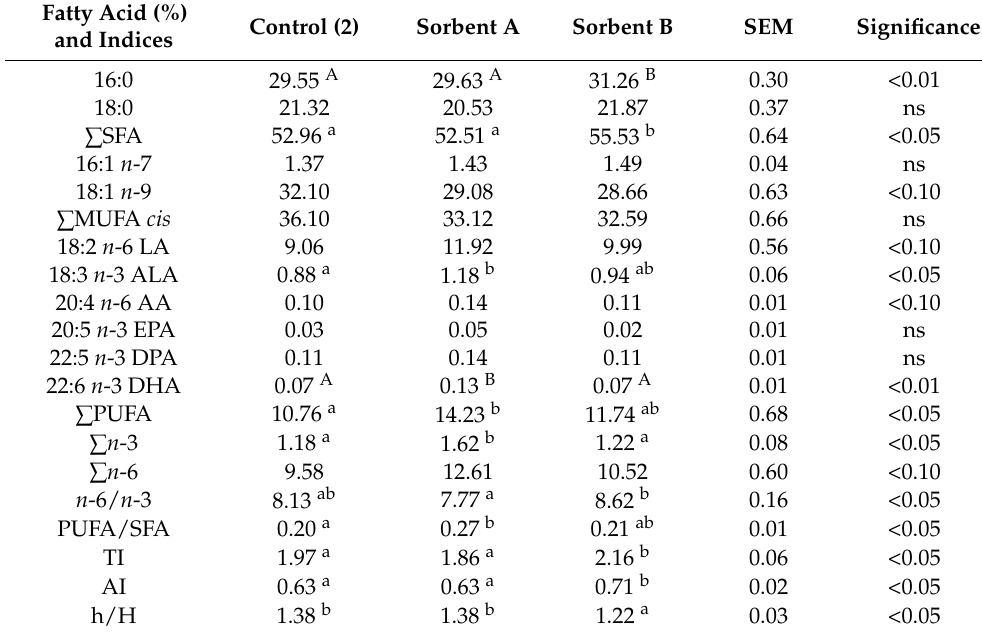
Table 4. Composition of fatty acid (% of total fatty acids) of kidney